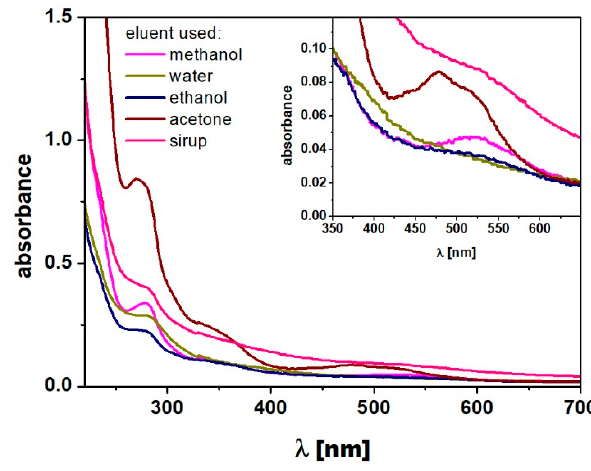
Figure 1. Absorption spectra of extracts and sirup.